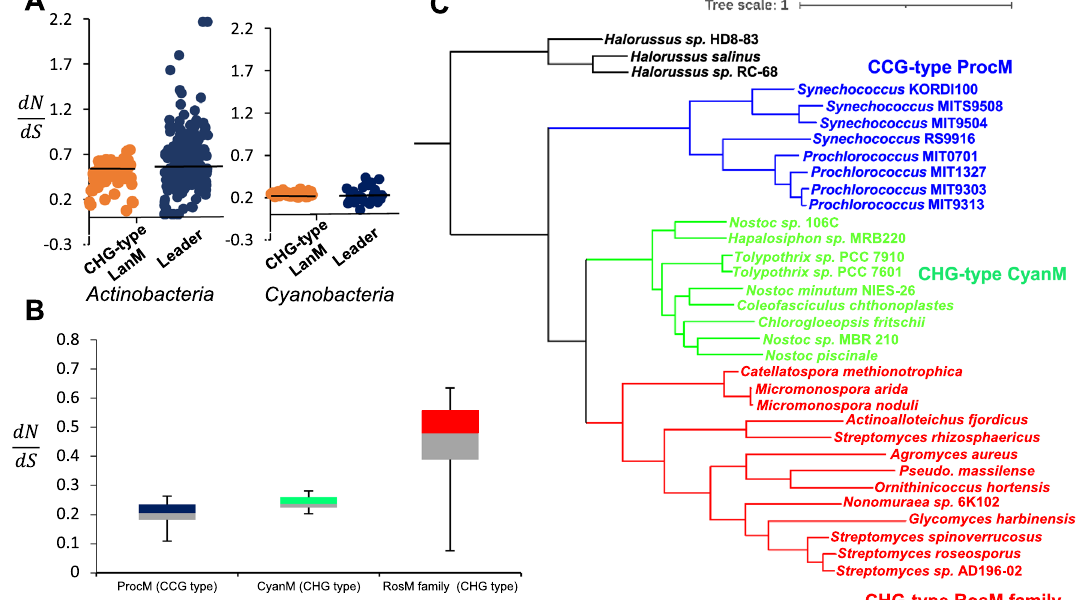
Fig. 6 Coevolution of lanthipeptide leader and synthetase in a phylum-dependent manner. A Pairwise d N /d S distribution of lanthipeptide leader and lanM from actinobacteria (13 BGCs of roseocin family) and cyanobacteria phylum (9 BGCs) showed variation in different phyla suggesting coevolution of the lanthipeptide leader and synthetases. B Standard box plot of the evolutionary rates of CCG motif prochlorosin family LanMs (Cubillos-Ruiz et al. 2017) (Additional file 1: Table S3) and CHG motif LanMs of cyanobacteria (from the current study) showed a similar pattern (median 0.21 and 0.24, respectively), while the CHG motif lanMs of roseocin family in actinobacteria has a higher value (median 0.48). In the standard box plot, the lower and upper shows the first and third quartile values, respectively, separated by the median value. The error bar plots the minimum and maximum values. C Phylogenetic tree of CCG motif ProcMs (Cubillos-Ruiz et al. 2017) and CHG motif LanMs of cyanobacteria and actinobacteria (from current study). Prochlorosin family LanMs displayed significant divergence from CHG motif LanMs of cyanobacteria and